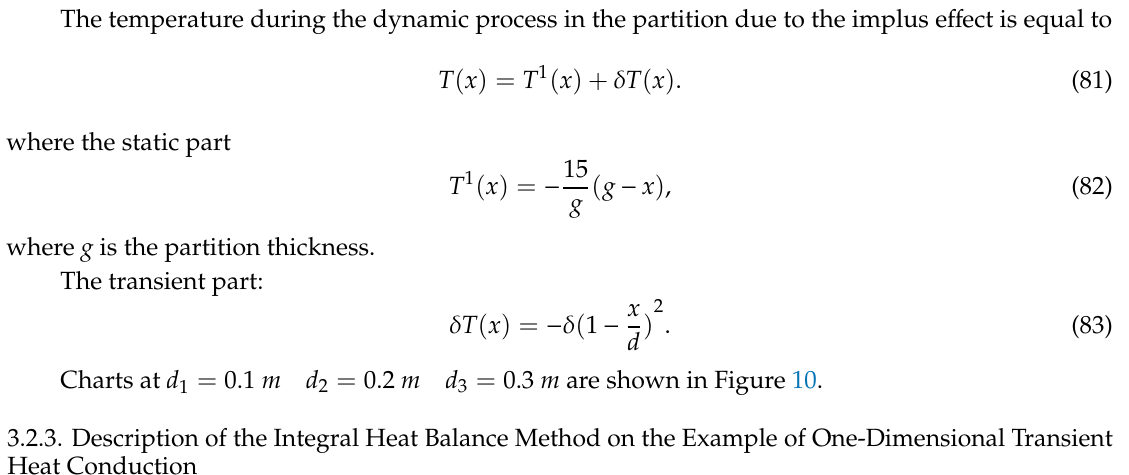
Figure 10. Graph of the temperature after the dynamic effect has occurred.